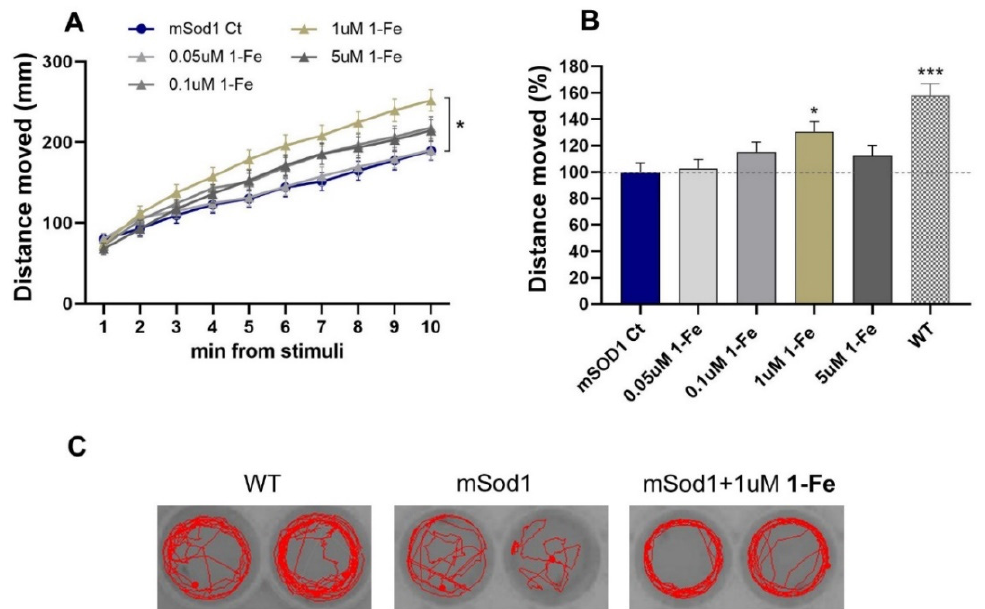
Figure 2. 1-Fe treatment improved mSOD1 larvae motor performance. (A) The distance that mSOD1 larvae swam per time bin of 1 min following light stimuli was averaged for all larvae. mSOD1 larvae were treated with either vehicle (0.1% DMSO; Ct), 0.05, 0.1, 1 or 5 μ M 1-Fe (* p < 0.05; linear mixed model, Tukey post hoc test, n = 94-6/group). (B) The change (%) in the distance